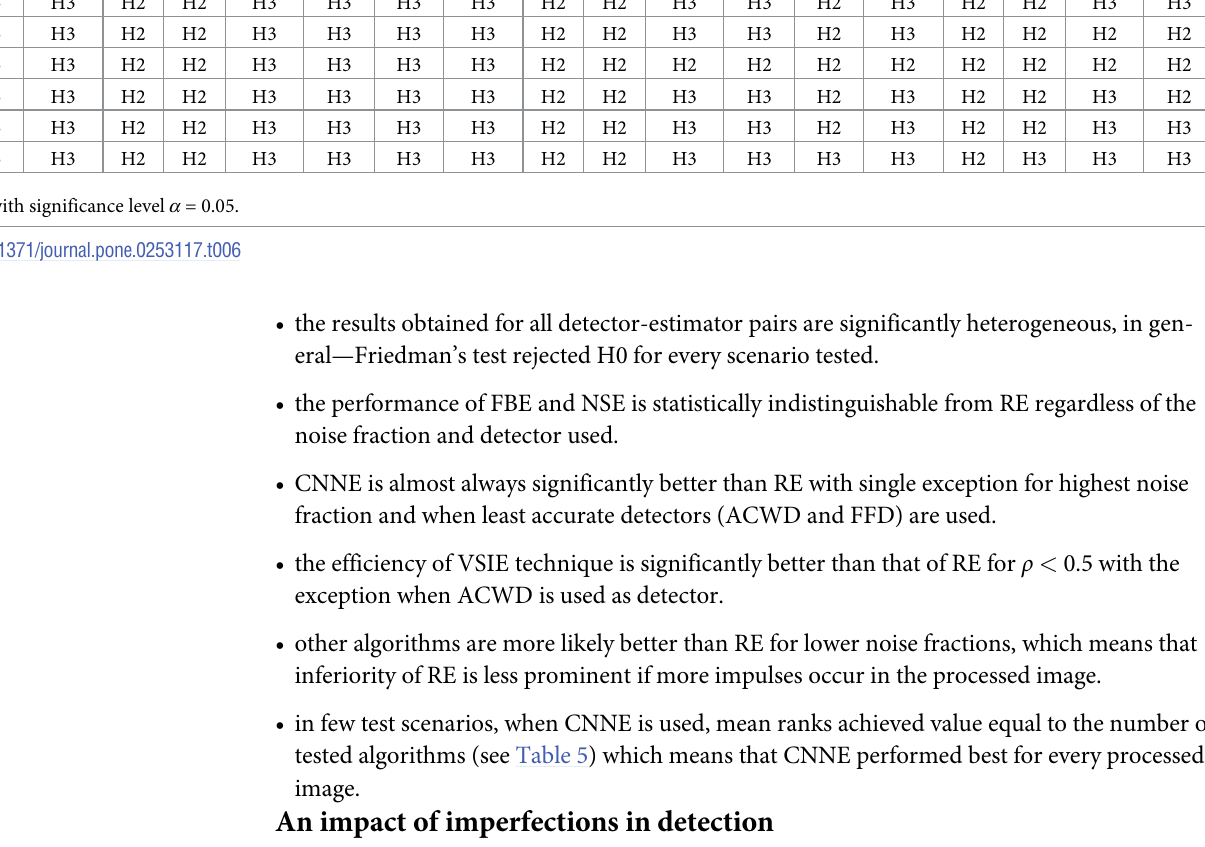
Table 6. Hypothesis for Post-hoc tests.